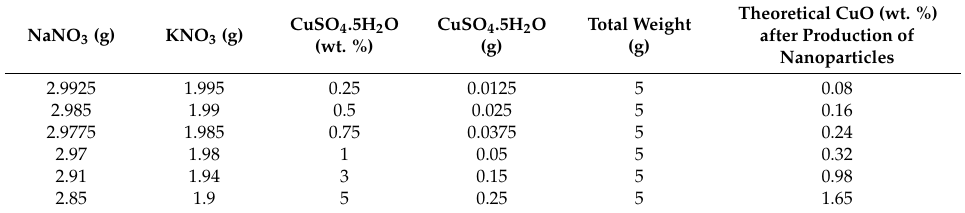
Table 2. Weight of samples used for the production of the different concentration of copper oxide nanoparticles in molten salt (the ratio of NaNO 3 to KNO 3 is always 60/40).